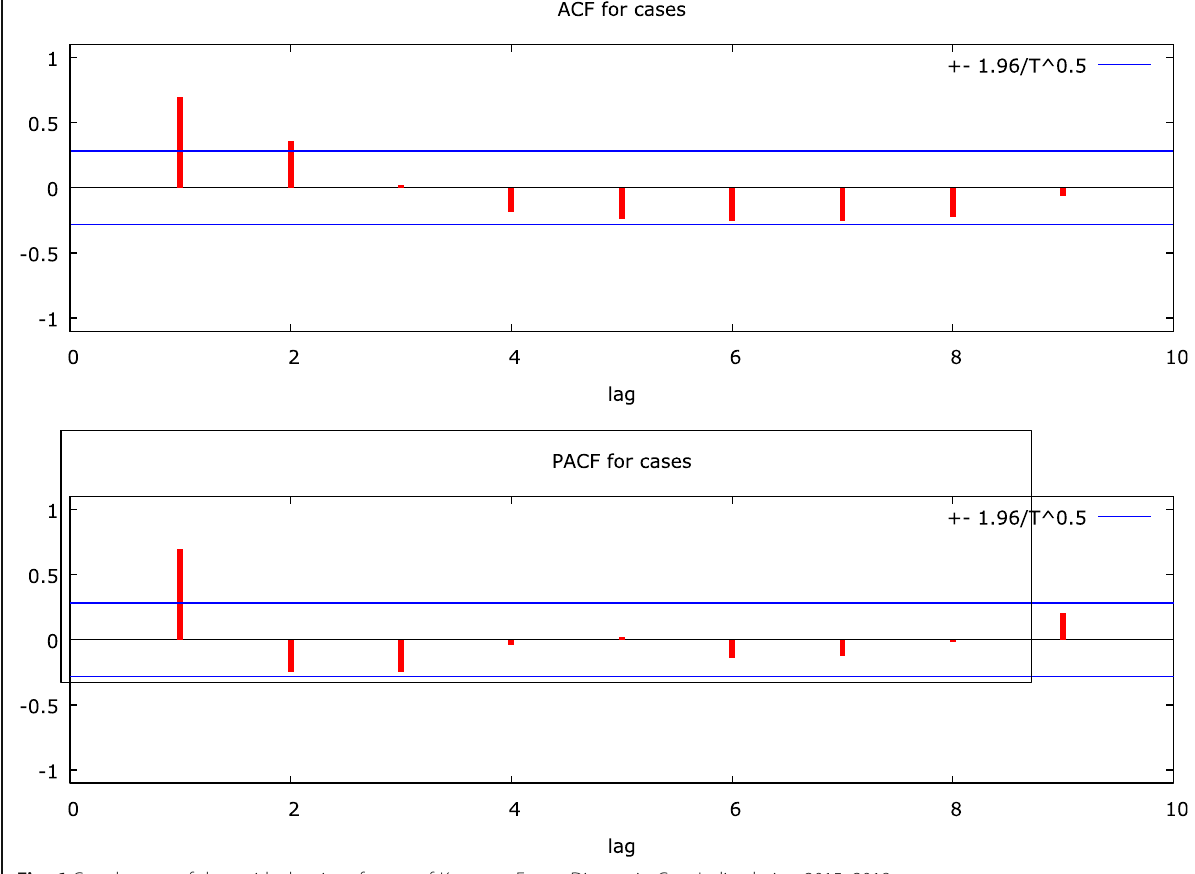
Fig. 6 Correlogram of the residual series of cases of Kyasanur Forest Disease in Goa, India, during 2015 – 2018